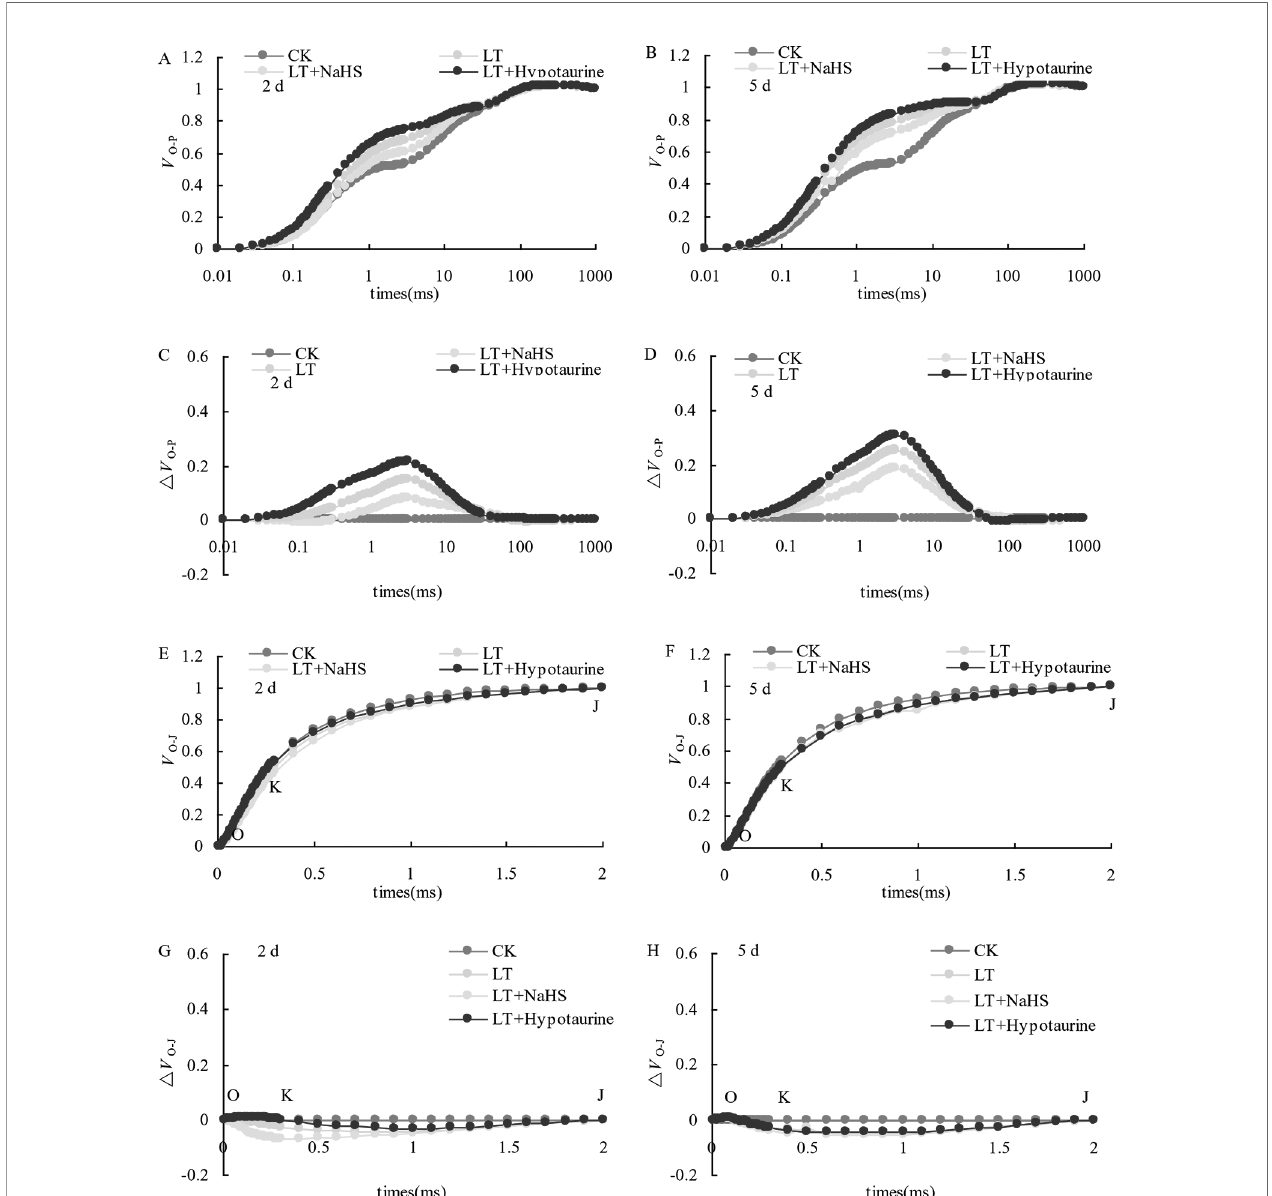
FIGURE 4 | Effects of exogenous NaHS and Hypotaurine on V O-P and V O-J curves of blueberry leaves under low temperature stress. The data in the fi gure are from fi ve replicated experiments (n = 5). CK: room temperature control at 25°C; LT: low temperature treatment; LT + NaHS: low temperature treatment at 4 – 6°C after spraying 0.5 mmol·L – 1 NaHS; LT + Hypotaurine: low temperature treatment at 4 – 6°C after spraying leaves with 200 m mol·L – 1 hypotaurine. OJIP curves of blueberry leaves in different treatments were standardized by O-P (VO-P) (A , B) . The difference ( D VO-P) between VO-P and CK (C , D) . OJIP curves were standardized by O-J (VO-J) (E , F) . The difference( D VO-J) between the VO-J curve and the CK (G , H) .